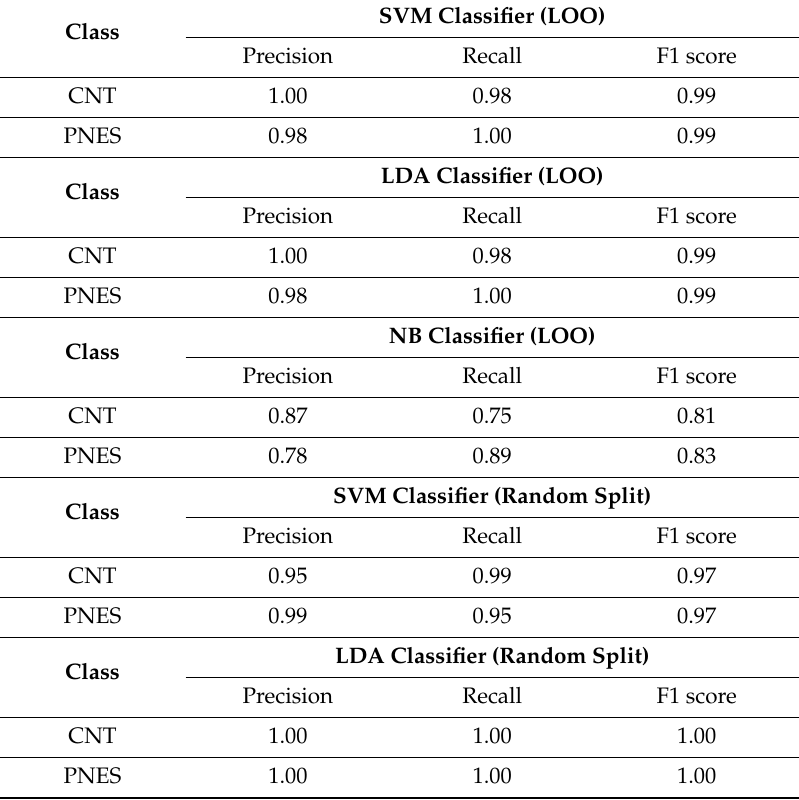
Table 1. The classification performance of psychogenic nonepileptic seizures (PNES) vs. health controls (CNT) in terms of precision (PR), recall (RC), and F1 score. We tested the discrimination performance among class labeled as CNT and PNES. The results obtained are quite comparable between the validation methods. The classifier performance provides us with values for each class under